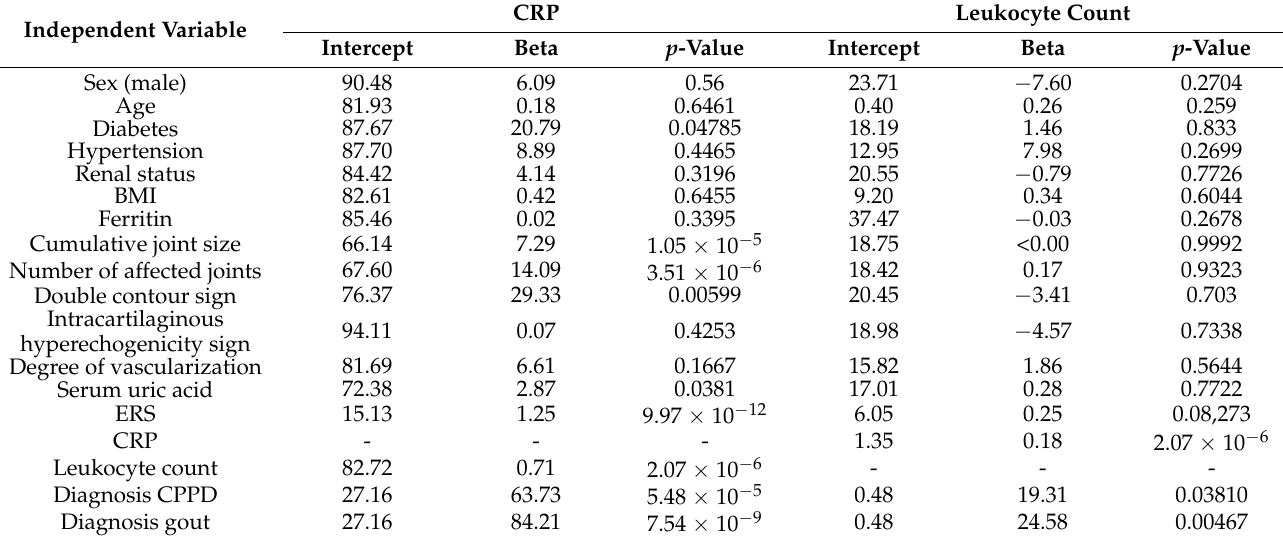
Table 5. Simple linear regression models for C-reactive protein (CRP) and leukocyte count in the aspirate versus biomarkers. Independent